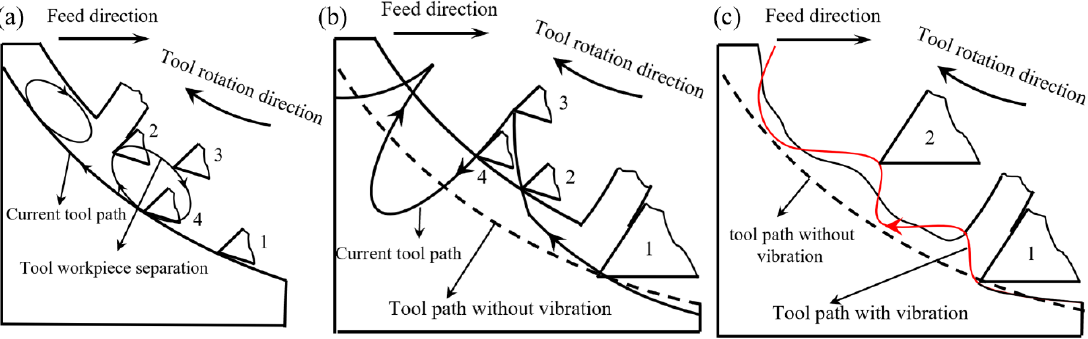
Figure 1. Three types of tool-workpiece separation conditions. ( a )Type I; ( b ) Type II; ( c ) Type III.